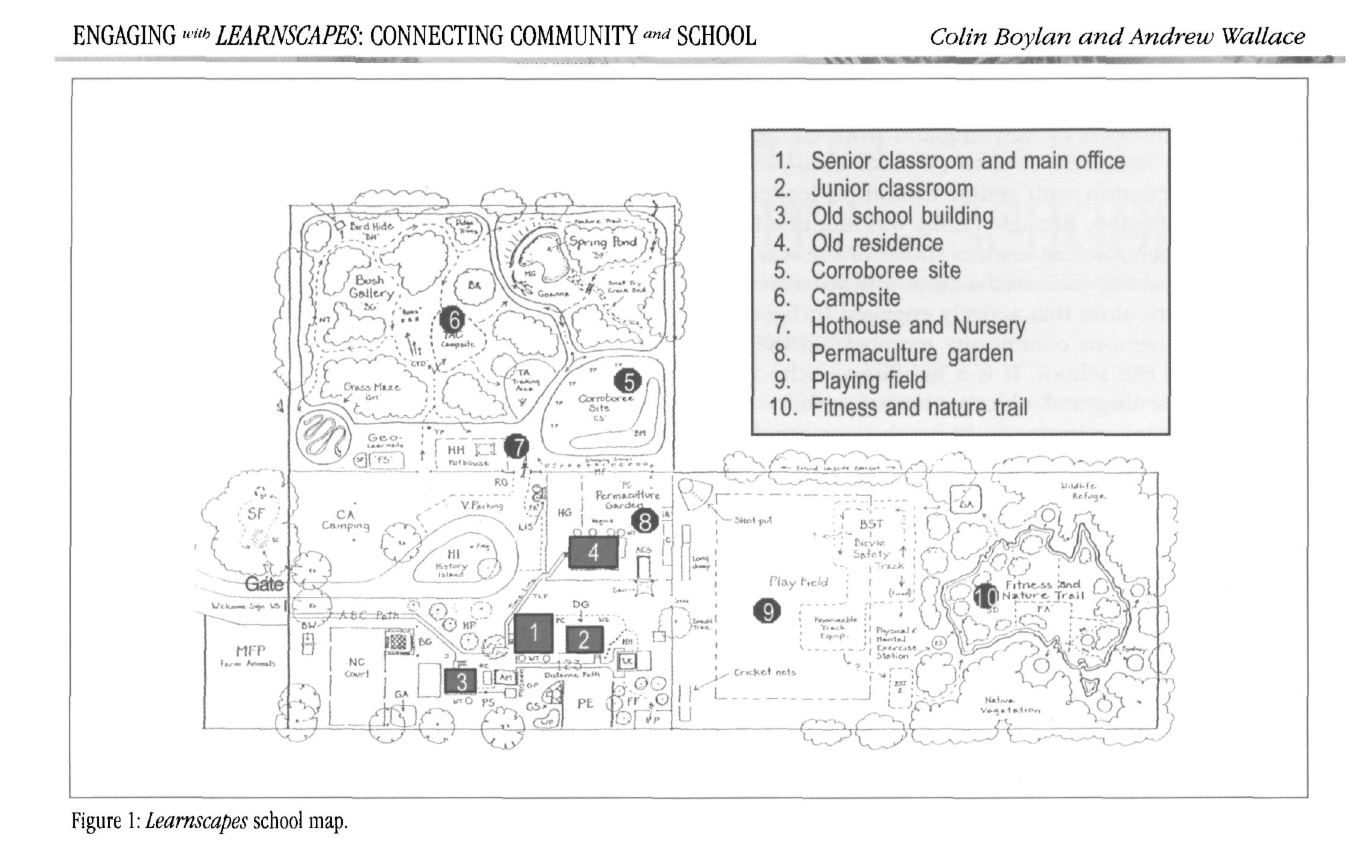
Figure 1: Learnscapes school